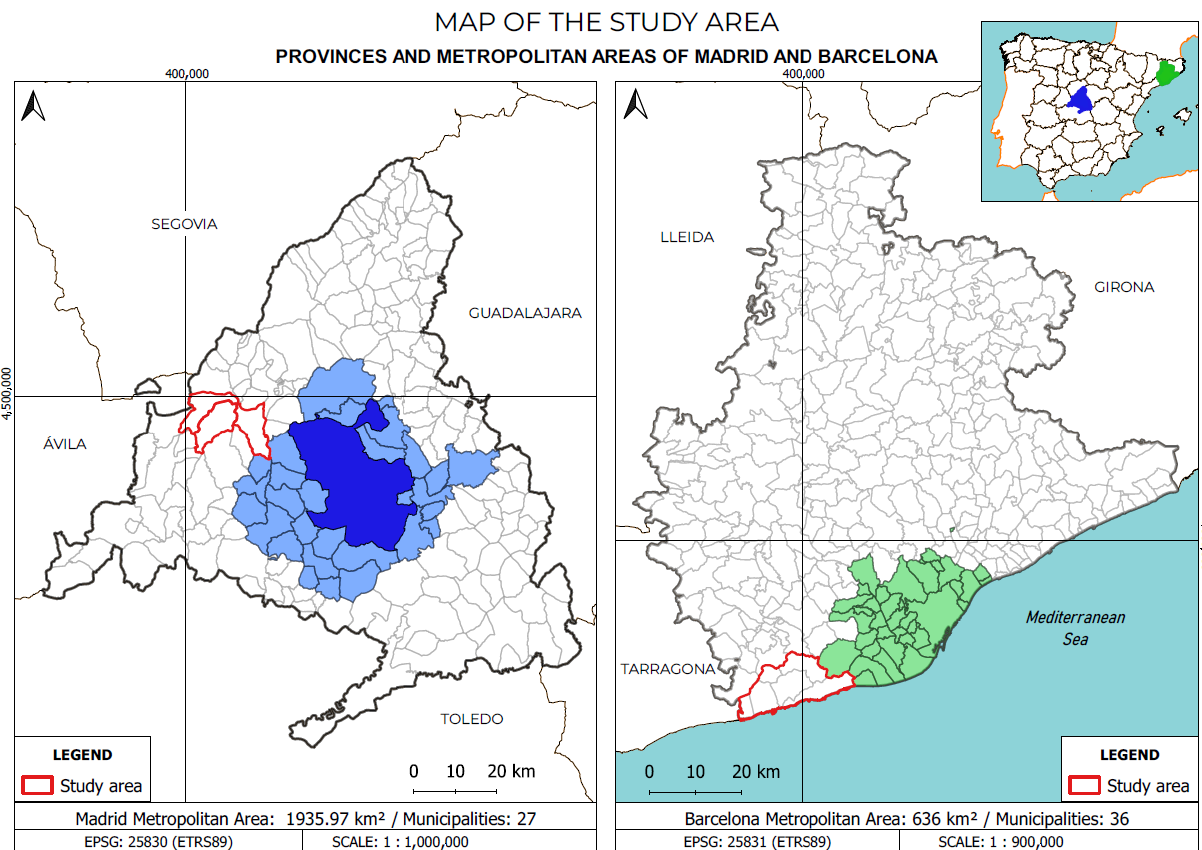
Figure 1. Location map of the metropolitan areas of Madrid and Barcelona and study areas where the methodology was tested in detail.